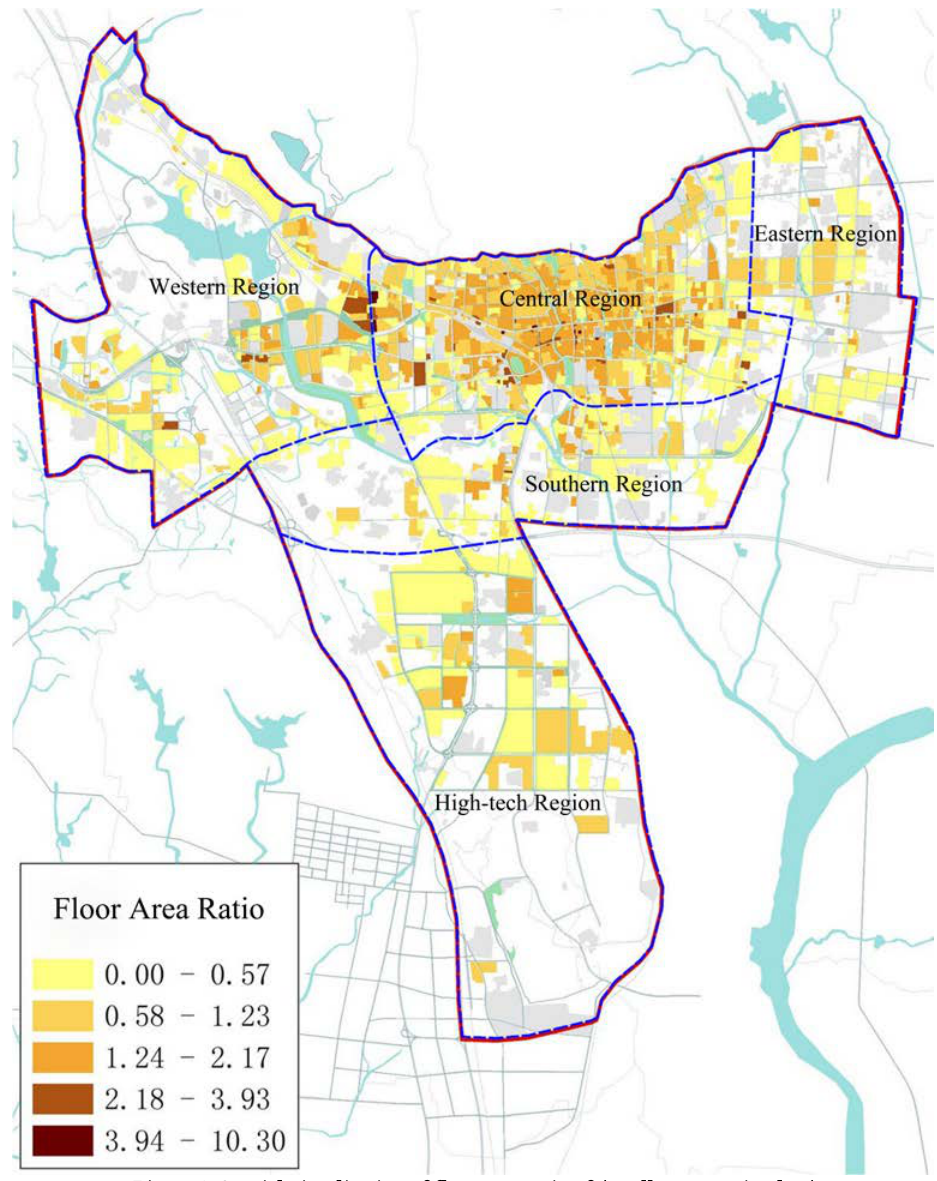
Figure 4. Spatial visualization of floor area ratio of the all construction land